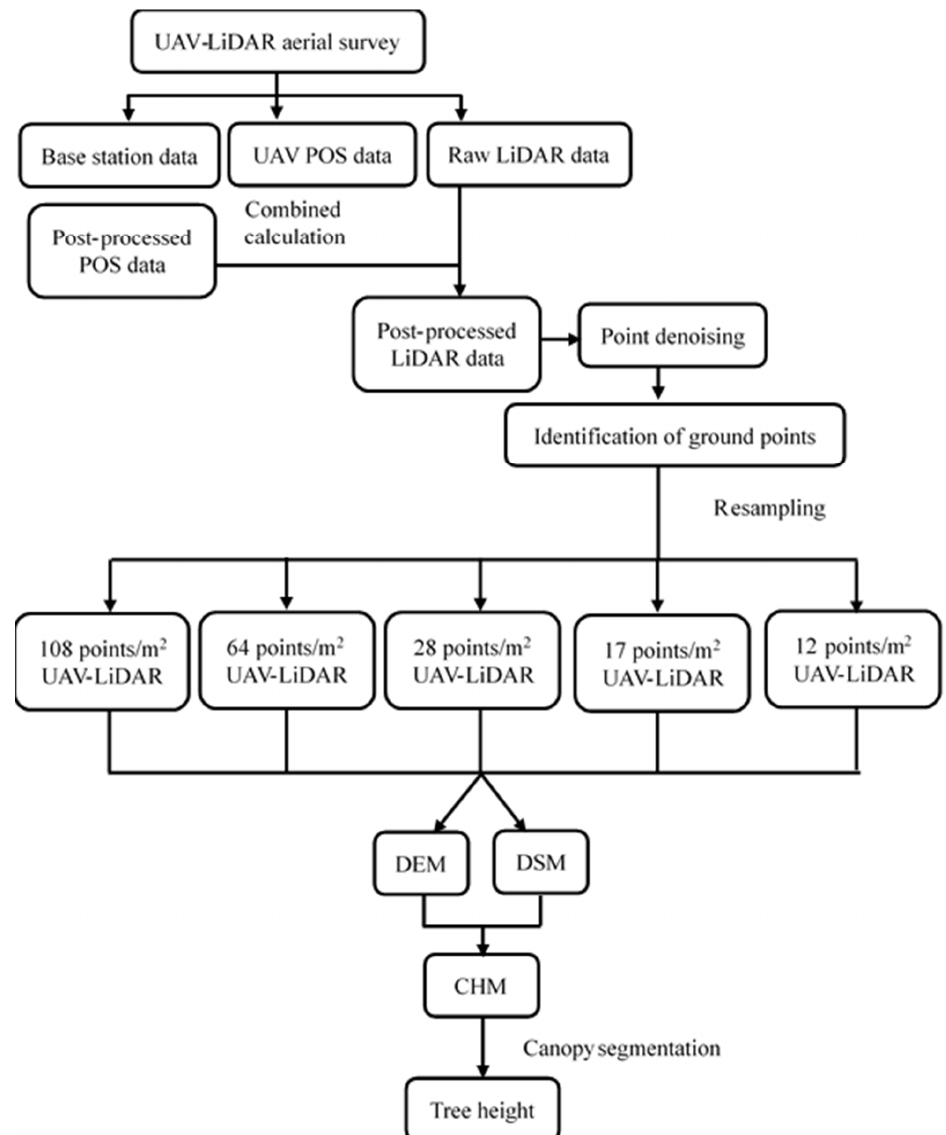
Figure 3. Tree height extraction flow chart.